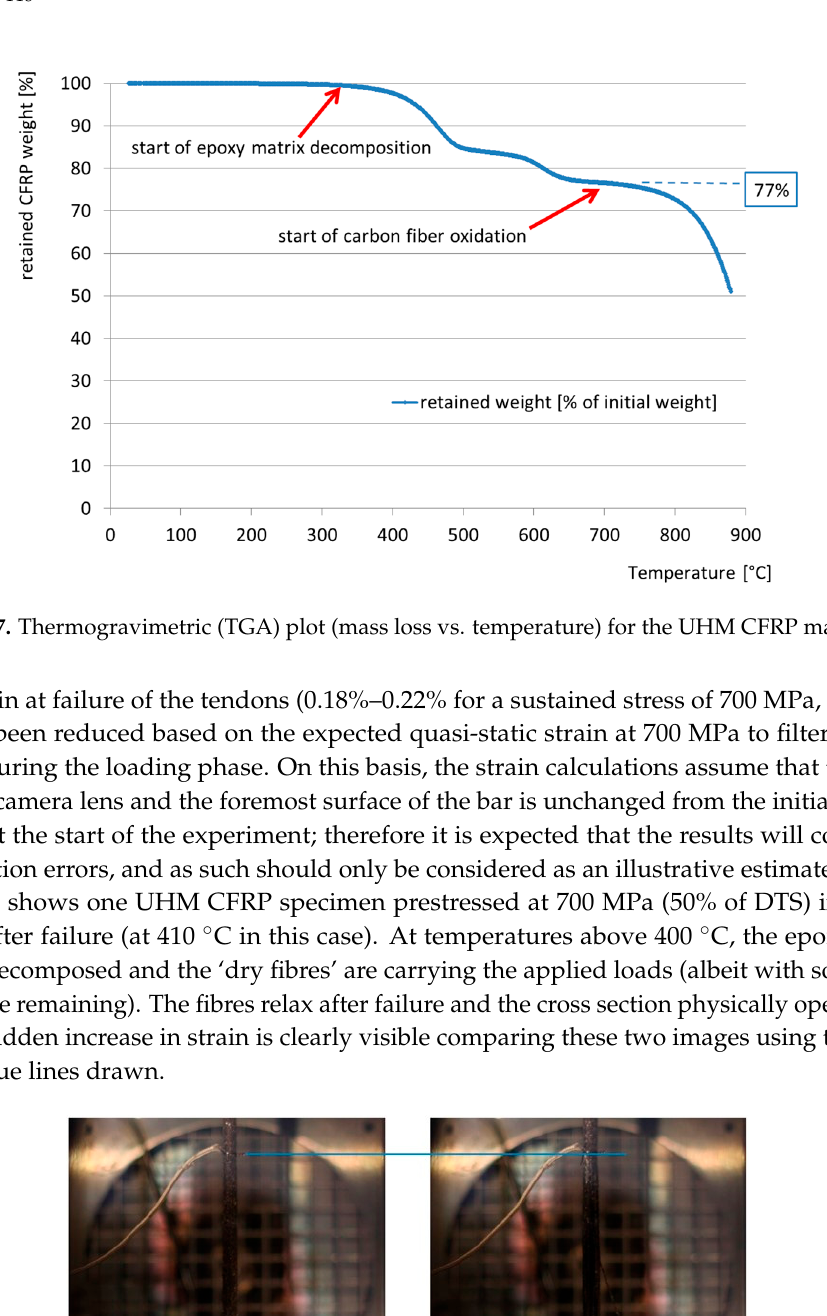
Figure 8. CFRP specimen prestressed at 700 MPa (Specimen 50d) immediately before ( a ) and after failure ( b ).